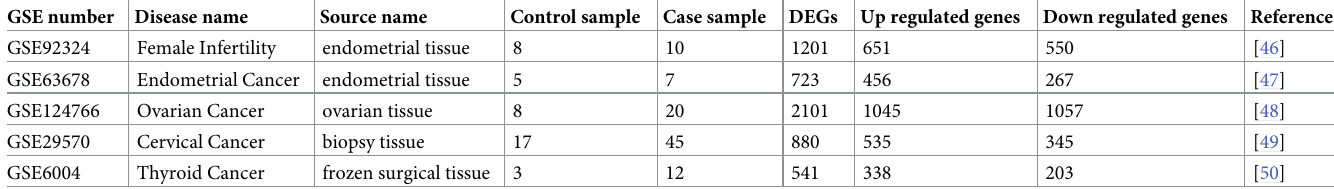
Table 1. An overview of datasets with their geo-features and quantitative measurements is